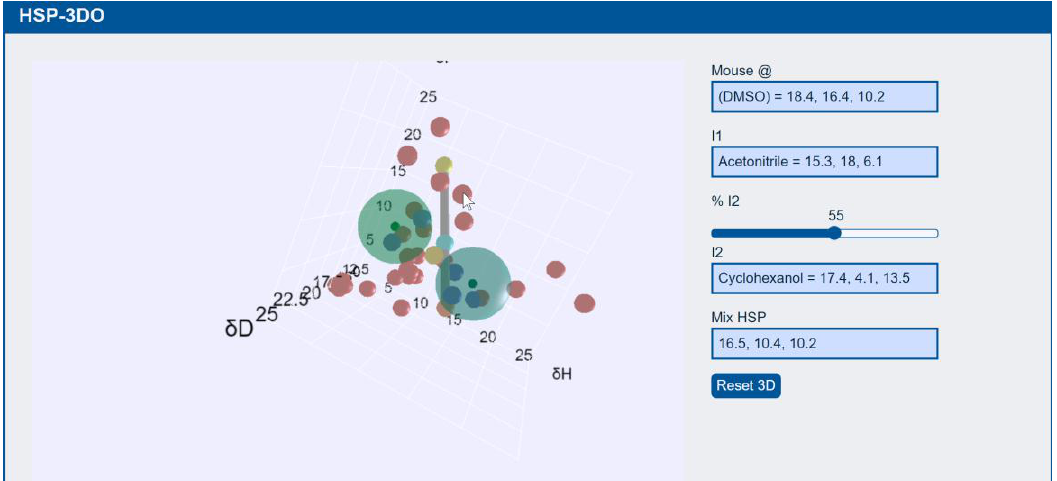
Figure 11. The screenshot tries to show how two rather incompatible materials (e.g., a polymer and nanoparticle) can be brought together via a mix of two rather bad solvents. The reader is urged to explore the app to get a better feel for what is going on. The app is at www.stevenabbott.co.uk/practical-solubility/HSP-3DO.php.